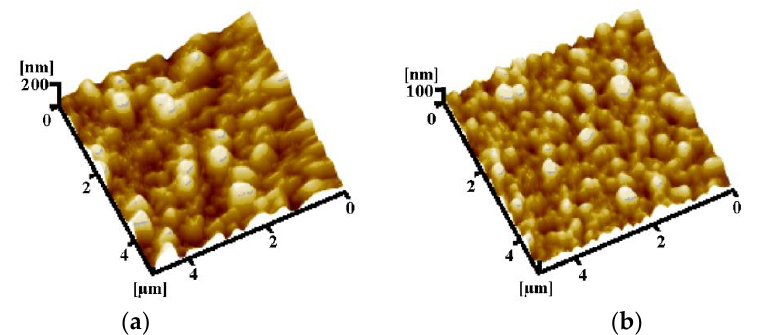
Figure 3. AFM surface morphologies: ( a ) the α -Si:H thin film and ( b ) the α -Si:H,N/ α -Si:H (N-5min) thin film.